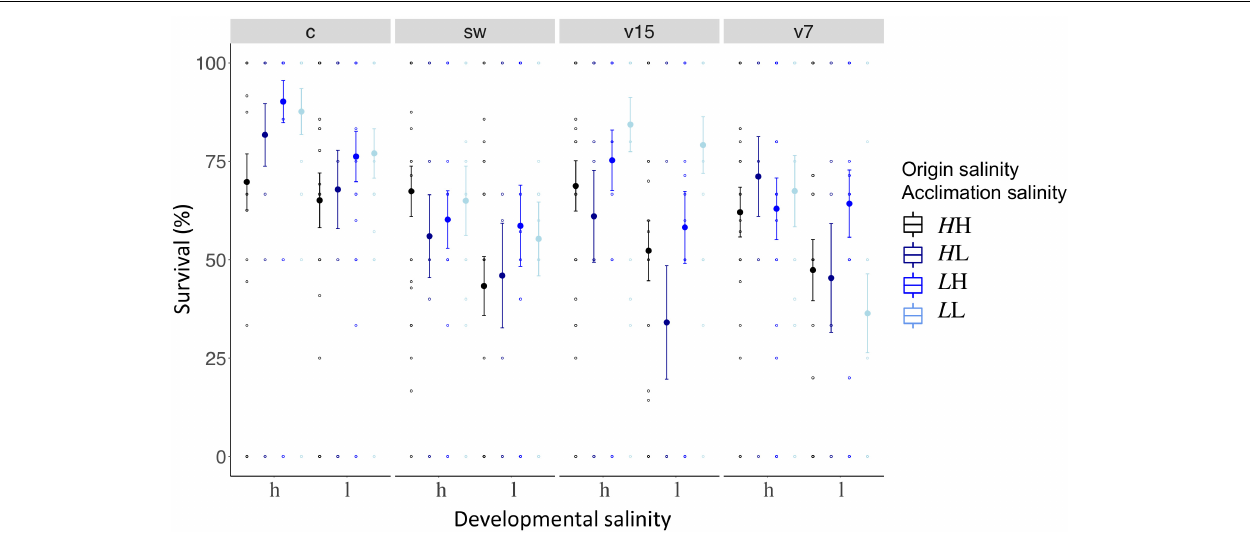
FIGURE 7 | Juvenile survival 6 days post infection. Juvenile survival 6 days post infection is plotted on the y -axis. The x -axis indicates the developmental salinity (h – high/15 PSU, l – low/7PSU). Italic letters and colors specify the origin salinity of the parental generation ( H : 15 PSU, black and dark blue; L : 7 PSU, blue and light blue). The 2nd letter and colors indicate the acclimation salinity in the lab (H: 15 PSU, black and blue; L: 7 PSU, dark and light blue). Each treatment is represented by one panel, i.e., control (c) or injection with seawater (sw), Vibrio strain evolved at 15 PSU (v15), or at 7 PSU (v7).